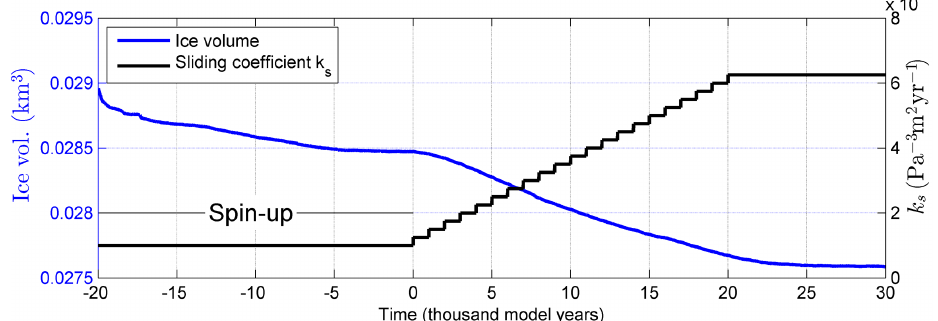
Figure 3. Change in ice volume (blue) of the NE Greenland model domain caused by the change in sliding coefficient (black) for the entire model